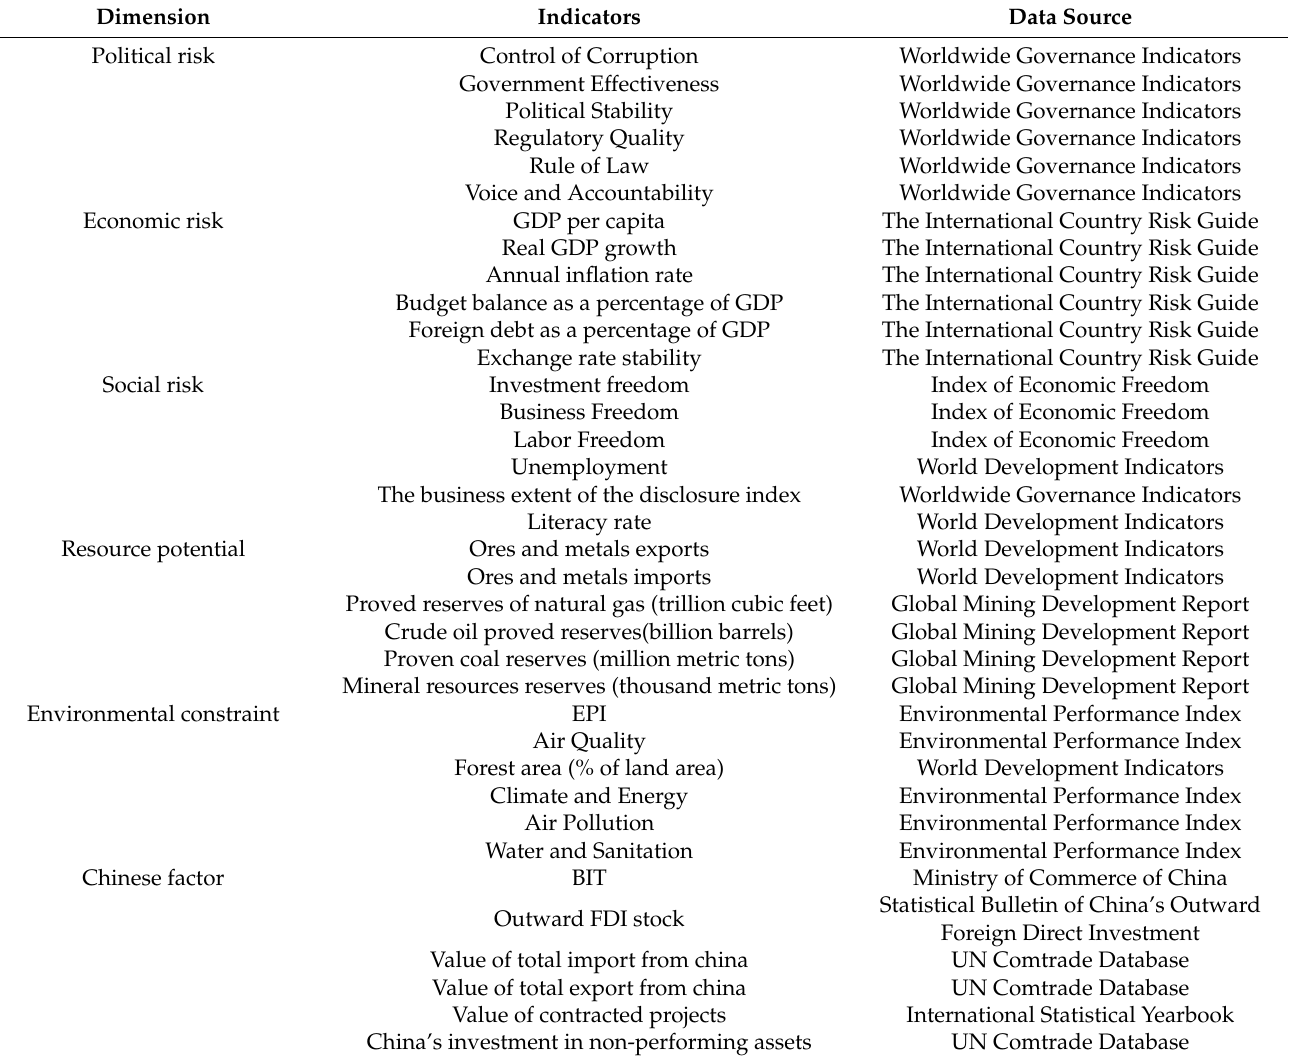
Table 2. Indicator system and data